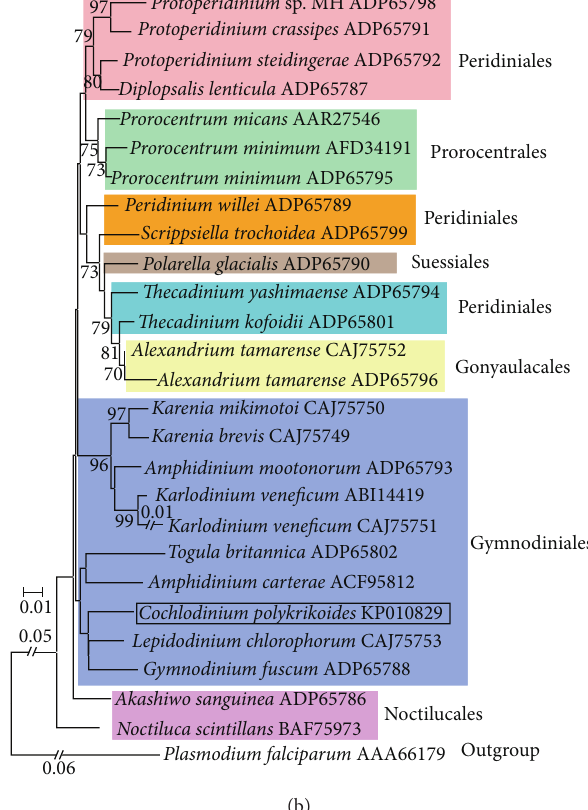
Figure 1: The cDNA and its predicted amino acid sequences of CpHSP90 and neighbor-joining tree of dinoflagellate HSP90s. (a) The cDNA and its predicted amino acid sequences: the conserved amino acids domains were marked in grey; the end domain “MEEVD” was boxed; (b) a neighbor-joining tree of dinoflagellate HSP90s. The phylogenetic tree was constructed in the MEGA 5 (bootstrap method with 1,000 replicates). The scale bar represents the number of amino acid substitutions per site. C. polykrikoides HSP90 was determined in the present study and marked in a box. Other dinoflagellate HSP90s and outgroup were obtained from NCBI